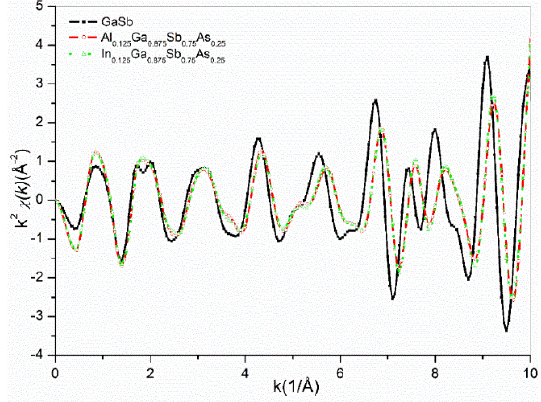
Figure 3. EXAFS scattering data of GaSb, (Al, In) 0.125 Ga 0.875 Sb 0.75 As 0.25 alloys. From k 2 -weighted curves of GaSb, Al 0.125 Ga 0.875 Sb 0.75 As 0.25 , and In 0.125 Ga 0.875 Sb 0.75 As 0.25 alloys (Figure 3), all samples scattering intensities have a high agreement on peak structures, while Al and In doped Ga samples have slight shifts at high k-values. The shift is a result of the atomic response of GaSb crystals to Al, In, and Sb doping in the Ga environment. The shift addresses atomic displacements in Ga coordination due to the influence of